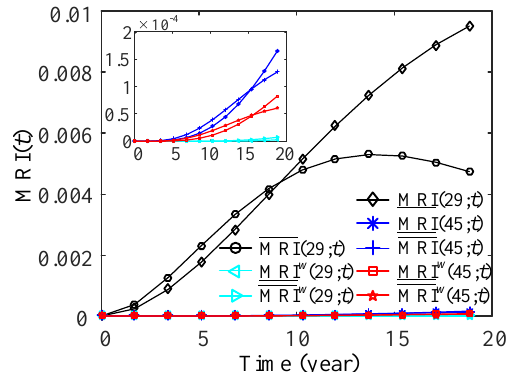
Figure 16. Lower and upper MRI of components 5 and 28.